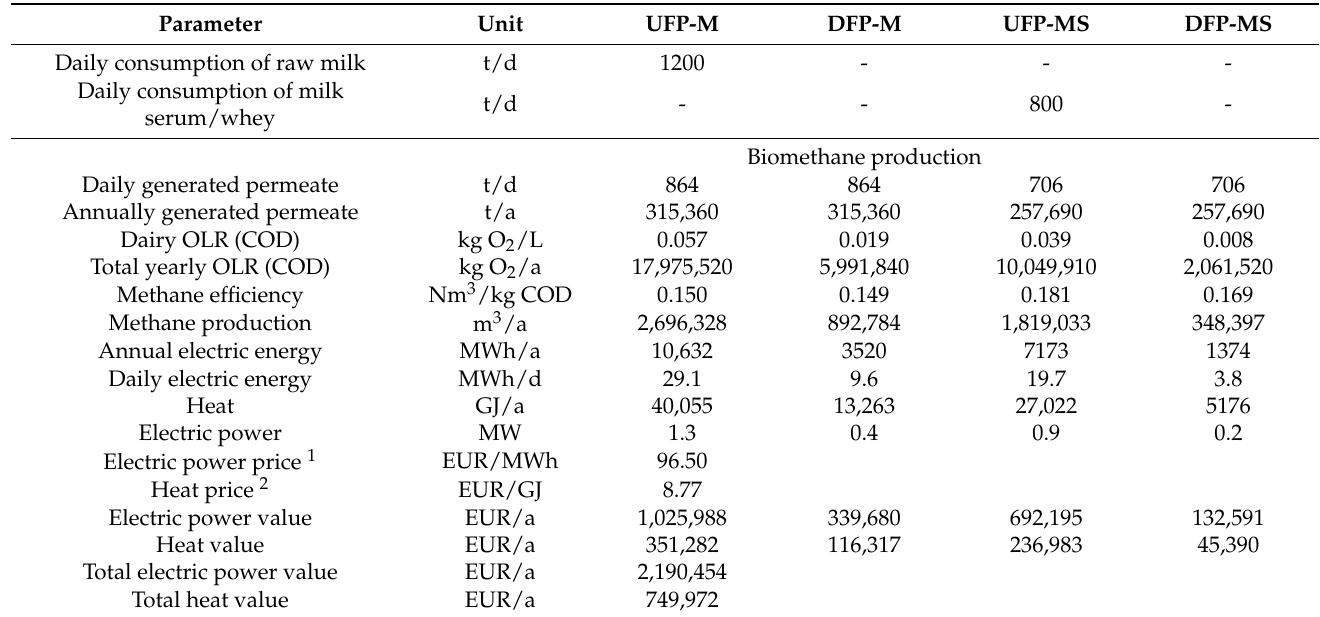
Table 6. Simplified possible electricity and heat production from dairy waste in comparison to lactose